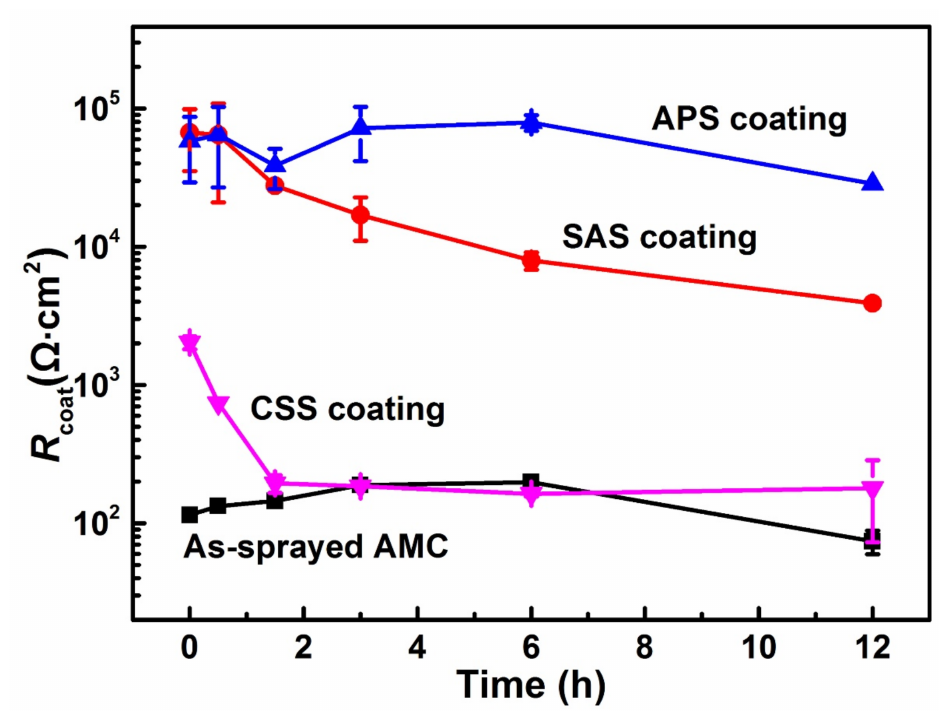
Figure 9. Variations of the resistance R coat for four coatings before and after erosion–corrosion for different